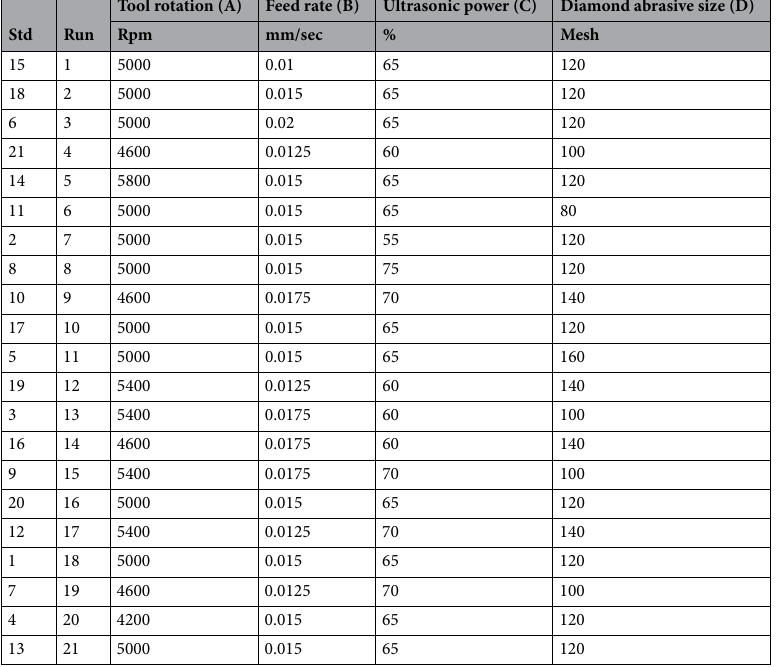
Table 3. Experimental design as per